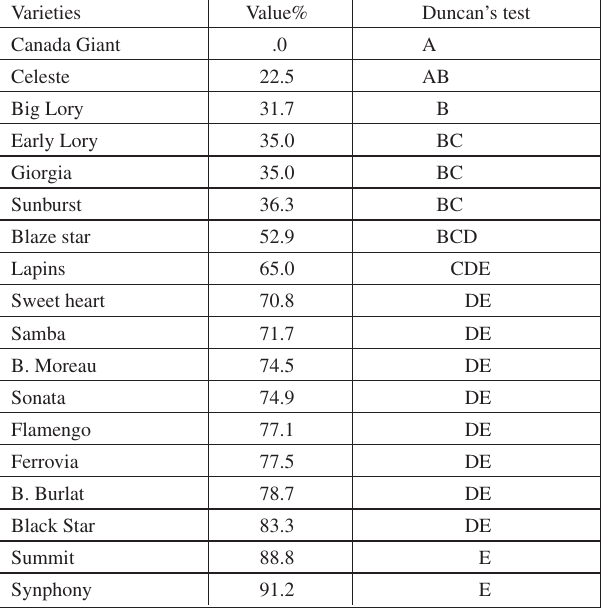
Table 2. Average of flowers percentage destroyed by spring frost, R t Varieties